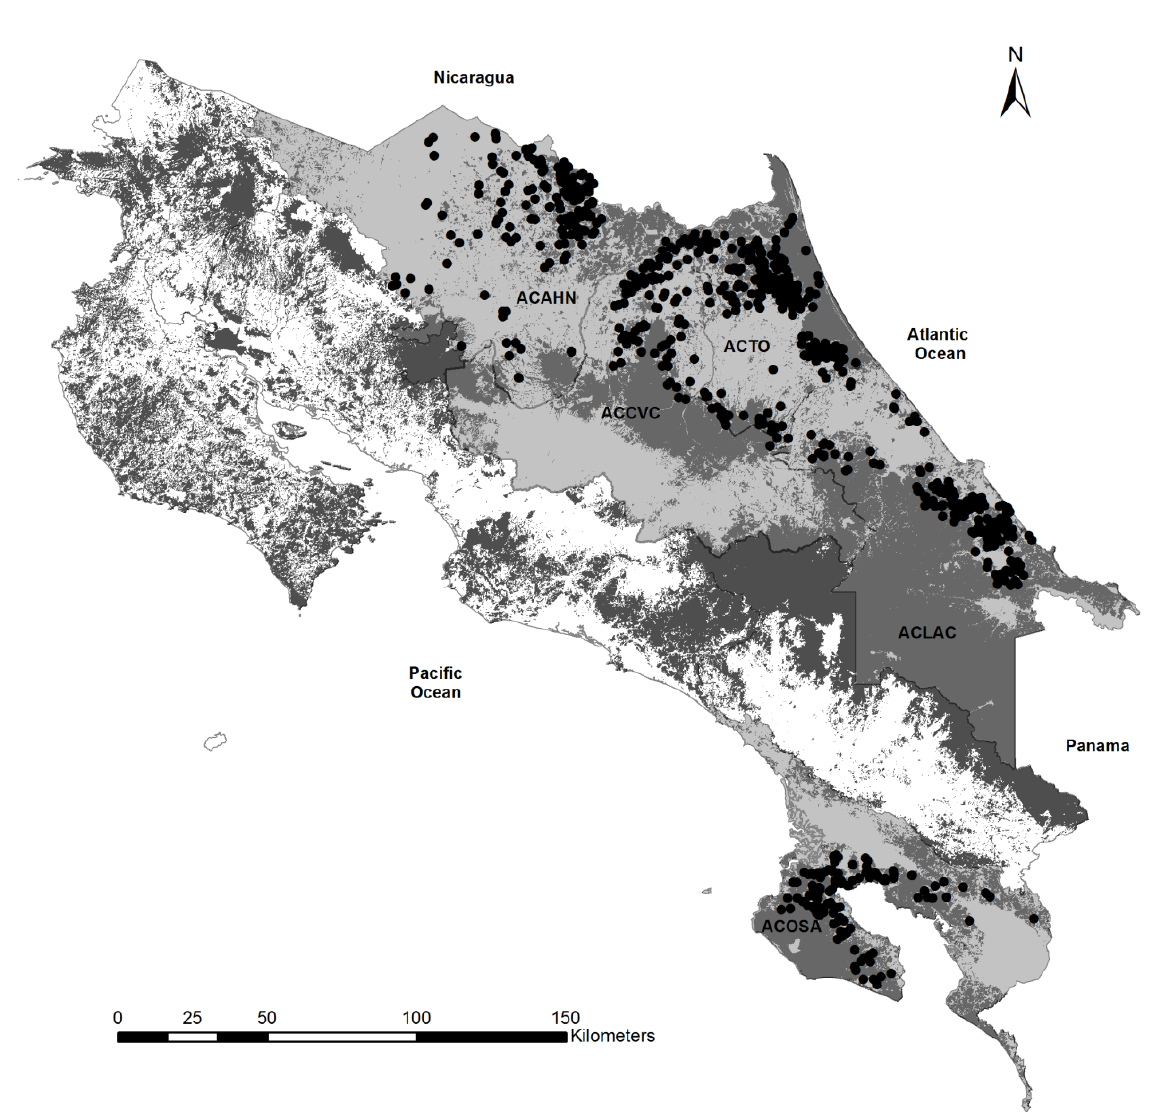
Figure 1. Location of forest management plans in Costa Rica (black dots) for five Conservation Areas based on the Forestry GIS: Huetar Norte Conservation Area (ACAHN), Coordillera Volcanica Central Conservation Area (ACCVC), Tortuguero Conservation Area (ACTO), La Amistad-Caribe Conservation Area (ACLA-C) and Osa Conservation Area (ACOSA); the darker areas in the map represent the forest cover for the year 2005. In general, forest management plans are located outside protected areas such as national parks and wildlife refuges (not shown here to avoid map clutter) in fragmented forests; the source for the original data is the National System of Conservation Areas archives of the regional offices, however, data presented here is based on work developed by [14,15]; areas for ACTO were provided by the regional office and rectified when